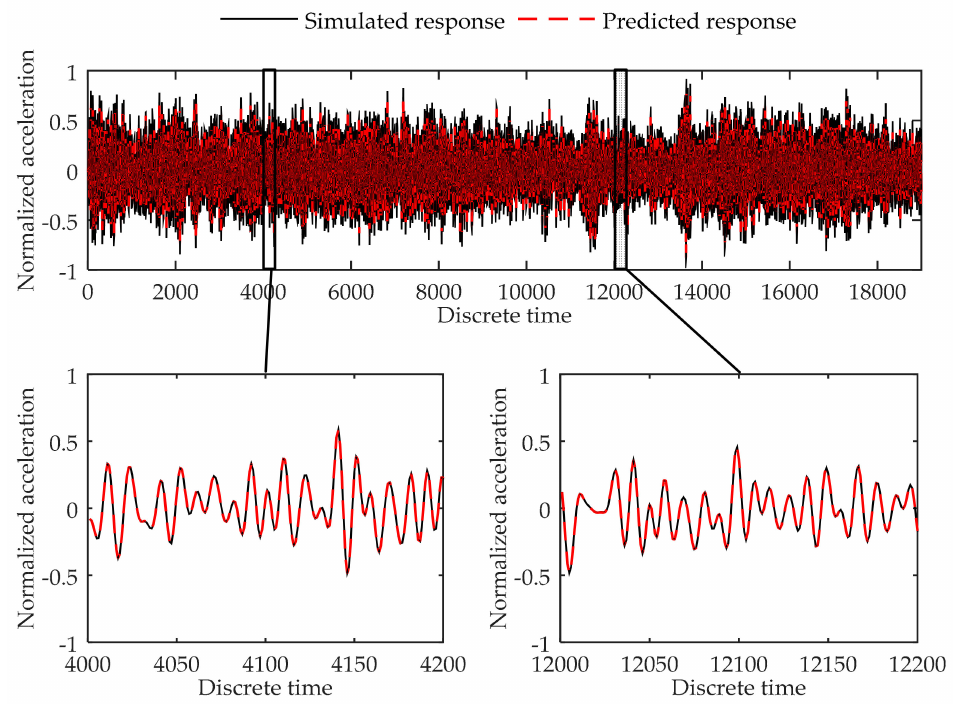
Figure 14. Comparison between the predicted response and real response of the location 6 at the simply supported beam experiment in Load Case 3-2.